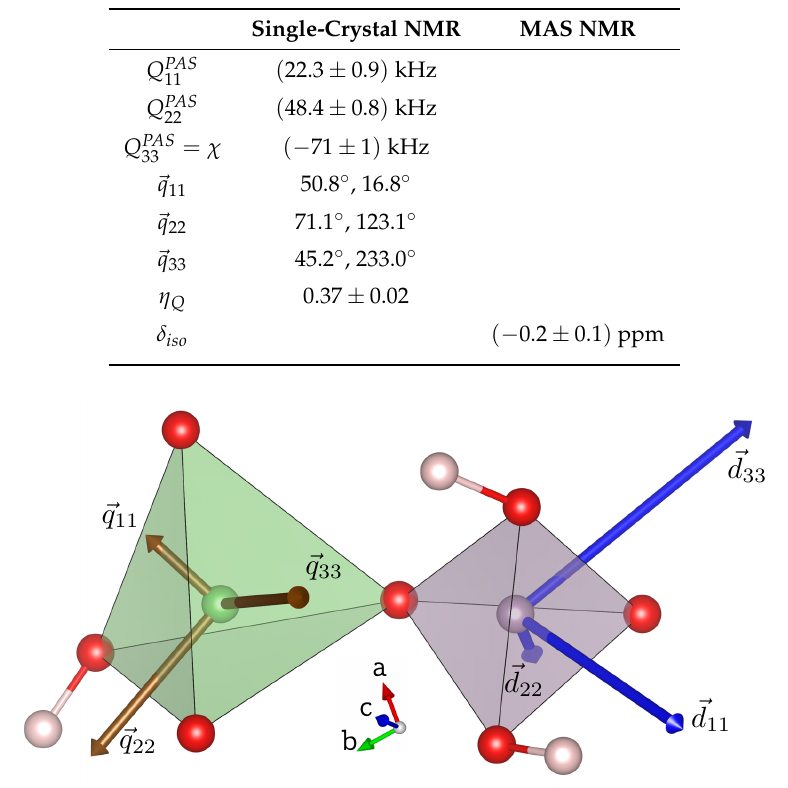
Table 2. Quadrupole coupling tensor Q Li (left), and isotropic chemical shift δ iso of 7 Li in LDP, LiH 2 PO 4 , from single-crystal NMR rotation patterns and magic-angle spinning (MAS) NMR. Eigenvector orientations are listed in spherical coordinates ( θ , ϕ ) in the orthorhombic abc crystal frame CRY . The errors of the experimental values reflect those delivered by the fitting routine.